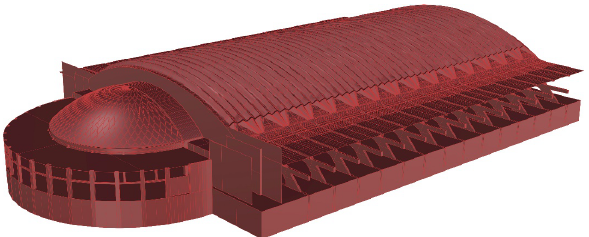
Figure 12 . Preliminary NURBS model of the pavilion B modelled following the described as-built strategies.